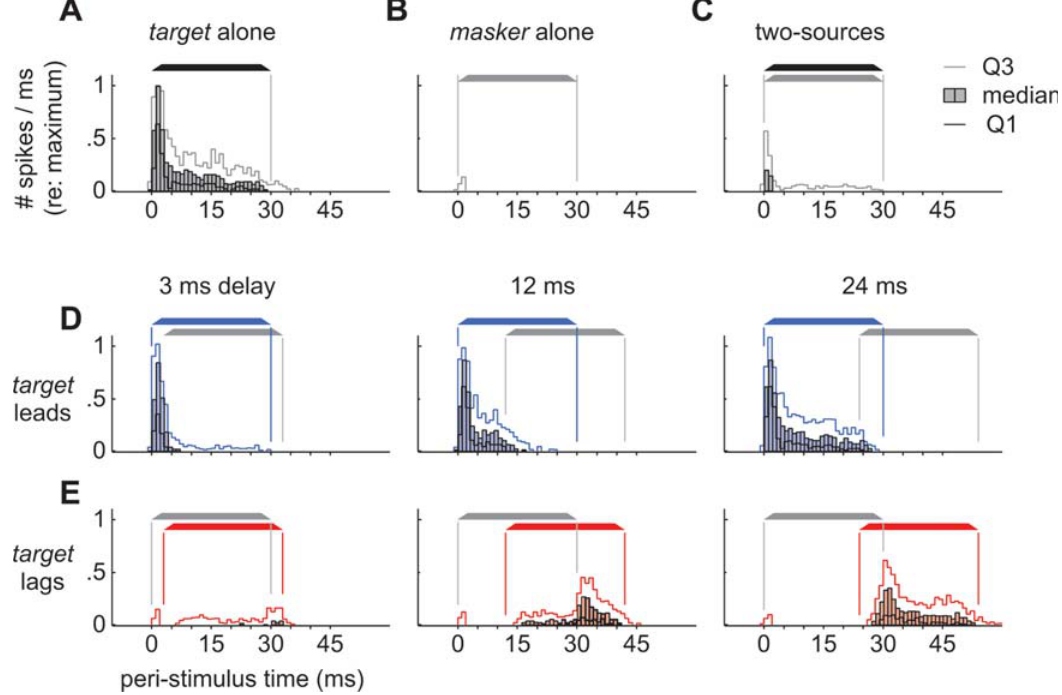
Figure 2. Peri-stimulus time histograms (PSTHs) showing neural responses evoked by a subset of stimuli. Each bar shows the median neural response ( . 50 repetitions/cell; 1-ms bins). Thin lines show the first and third quartiles (Q1, Q3). Each cell’s response was normalized to the maximum number of spikes evoked, within a single bin (usually the first or second bin after 0-ms), by 30 ms noise-bursts presented from the center of each cell’s SRF [11]. ( A ) Responses evoked by a single 30 ms target . ( B ) Responses evoked by a single 30 ms masker . ( C ) Responses evoked by two, simultaneous, uncorrelated, noise-bursts presented from both the masker and target loci. ( D ) Responses evoked when the target led by 3, 12 or 24 ms. ( E ) Responses evoked when the target